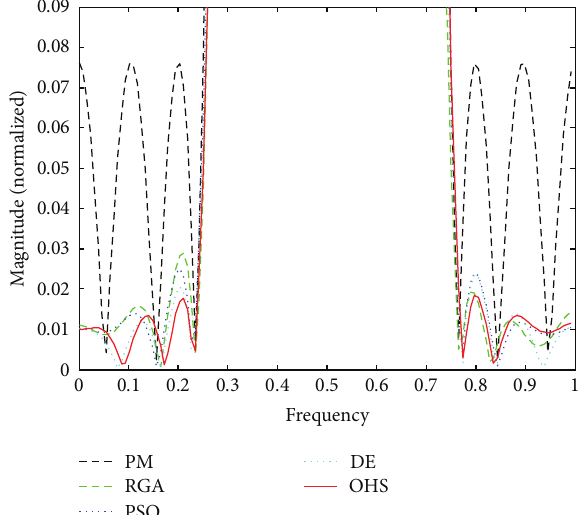
Figure 12: Normalized stop band ripple plots for the FIR BP filter of order 20.